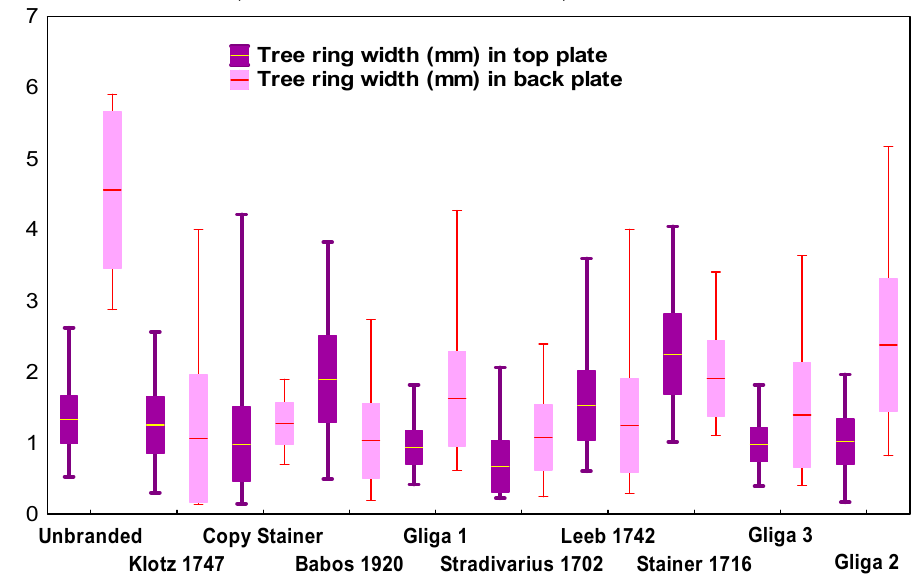
Figure 5. The variation of the annual ring width of the top and back plates of the analyzed violins. Table 1. Anatomical characteristics of spruce and maple wood on the front and back plates of the studied violins. Anatomical Characteristics—Mean (STDV)